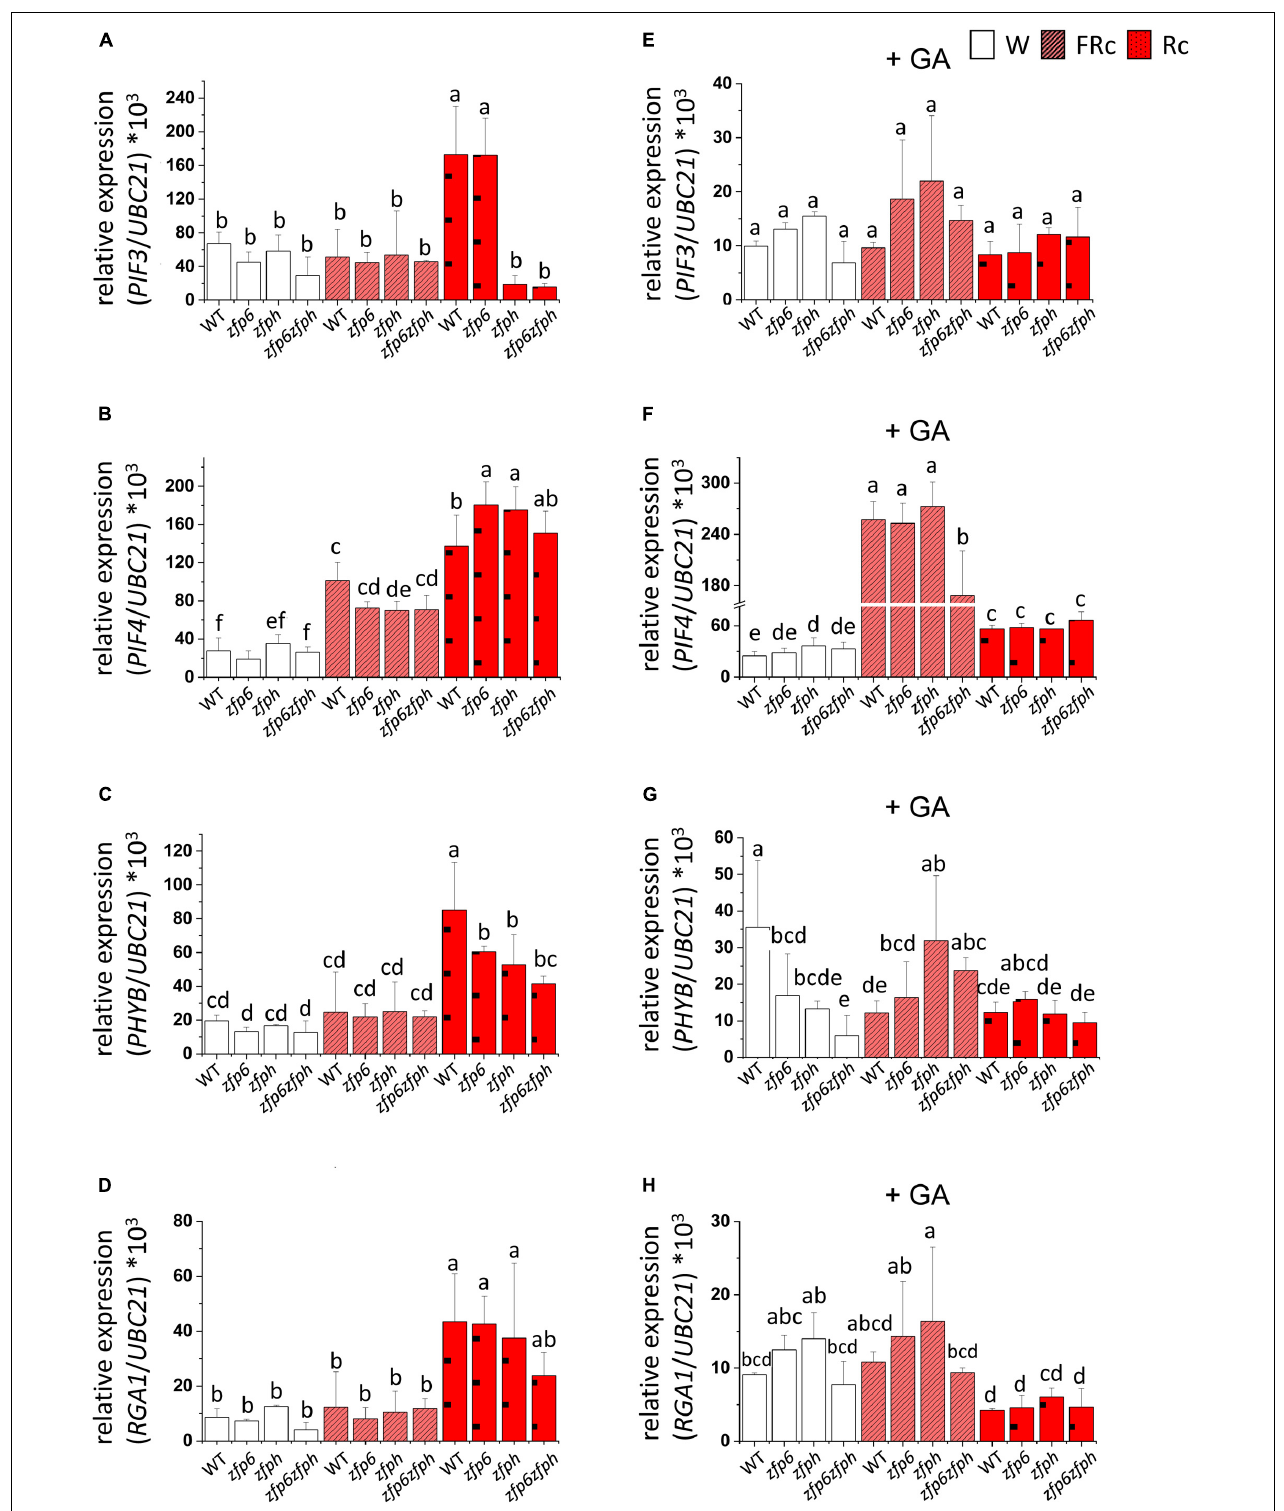
FIGURE 6 | PIF3 , PIF4 , PHYB , and RGA1 expression in seedlings grown in white, far-red, and red light conditions with or without GA. Seedlings were stratified at 4 ◦ C for 4 days in darkness and then incubated for 7 days at 22 ◦ C in white (W; 110 µ mol m − 2 s − 1 ), continuous far-red (FRc; λ max ∼ 735 nm at 5 µ mol m − 2 s − 1 ), or continuous red (Rc; λ max ∼ 670 nm at a fluence ∼ 25 µ mol m − 2 s − 1 ) in the absence (A–D) or presence of GA (+ GA; E–H ). UBC21 was used as the reference gene and the expression data was calculated using the 2 − (cid:49) CT method. Bars with different letters are significantly different.